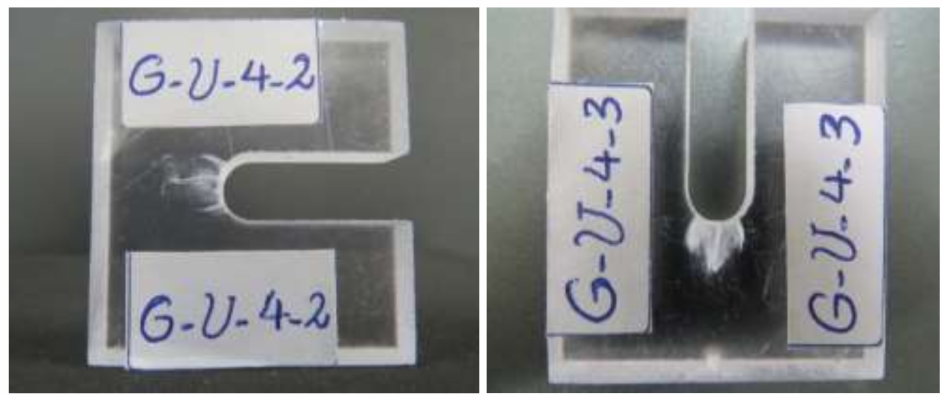
Figure 7. Example of two tested specimens made of GPPS ( ρ = 4.0